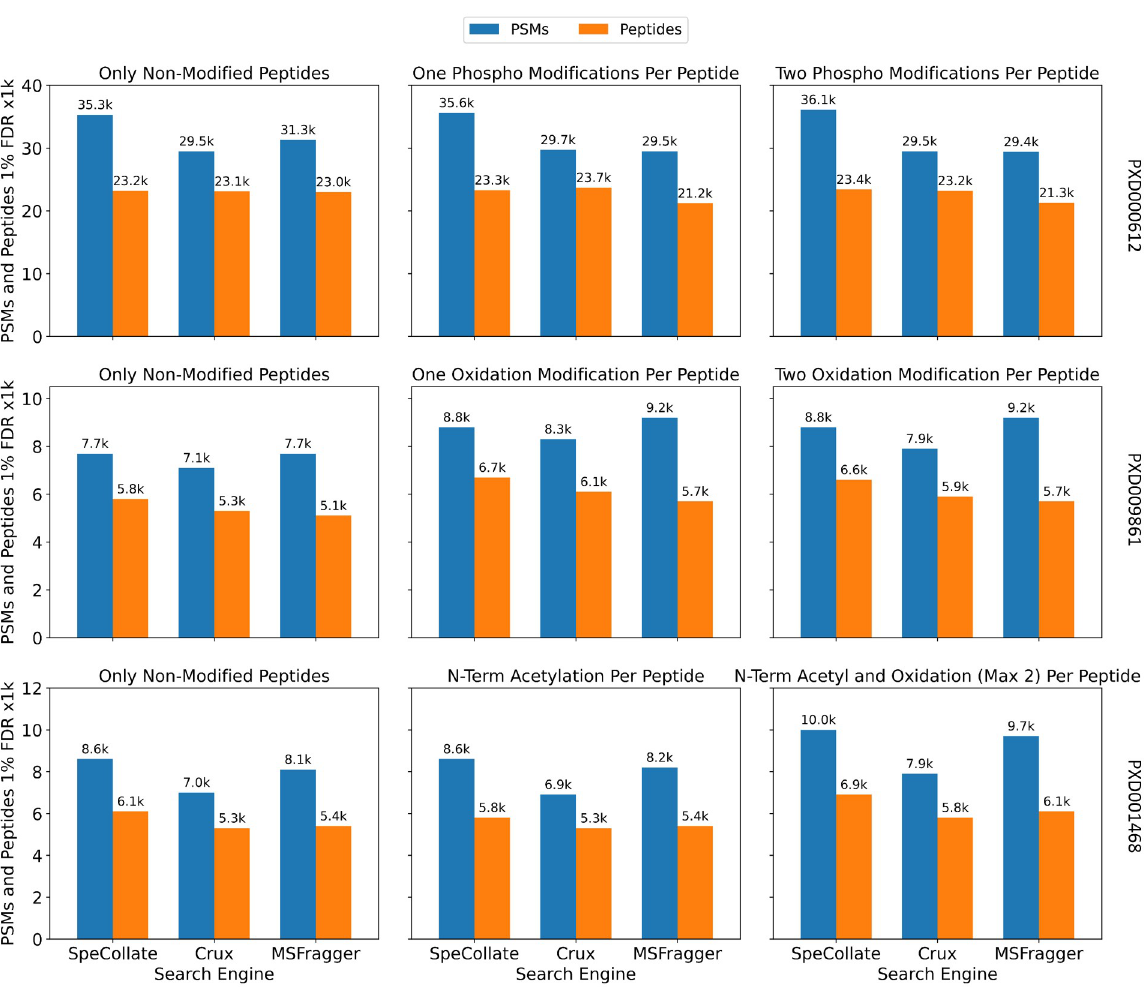
Fig 10. Closed search ( ± 5ppm) comparison against Crux and MSFragger using real-world data from PRIDE repository PXD000612 (top), PXD009861 (middle), and PXD001468 (bottom). For PXD000612, the search is performed against a peptide database generated from the human proteome with zero and up to one and two phosphorylation (amino acids S, T, and Y) modifications for subplots left, middle, and right, respectively. For dataset PXD009861, the search is performed against databases with a different number of oxidized M-residues (up to two per peptide), while for dataset PXD001468, the search is performed against a database with one n-term acetylation and up to two oxidation sites (max two modifications per peptide). SpeCollate can outperform Crux and MSFragger in terms of PSMs while giving a comparable performance in terms of the number of